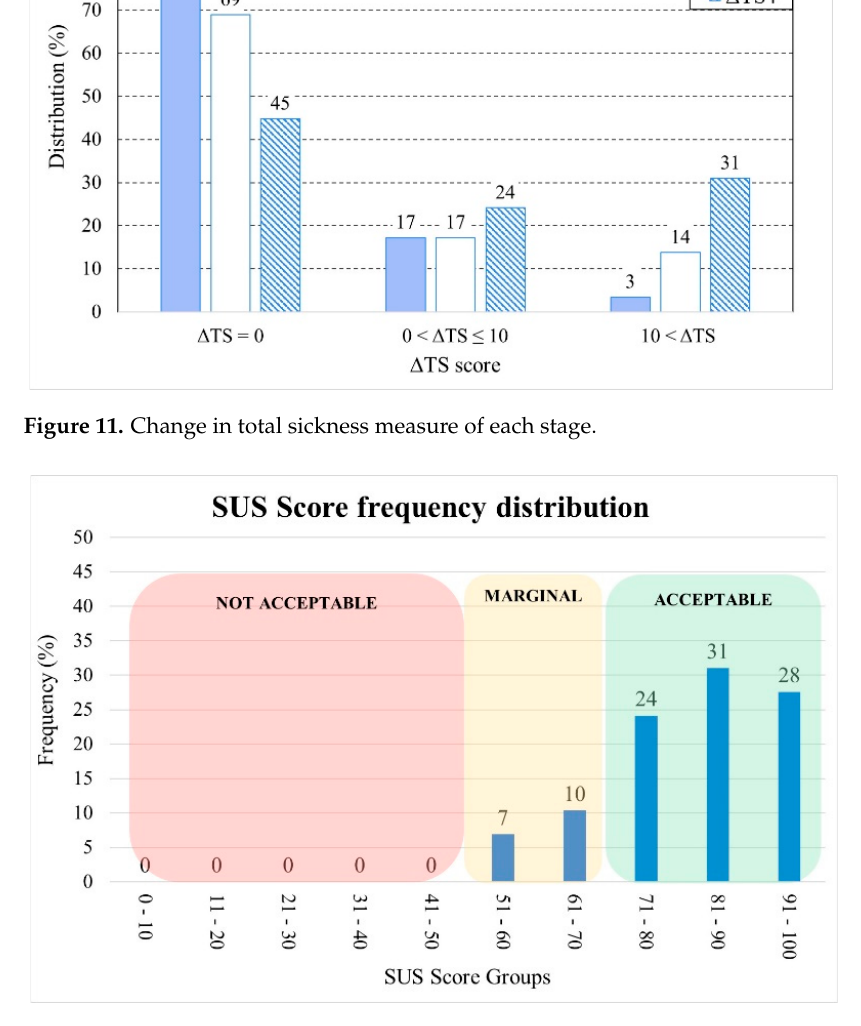
Figure 12. SUS score frequency distribution across all participants.